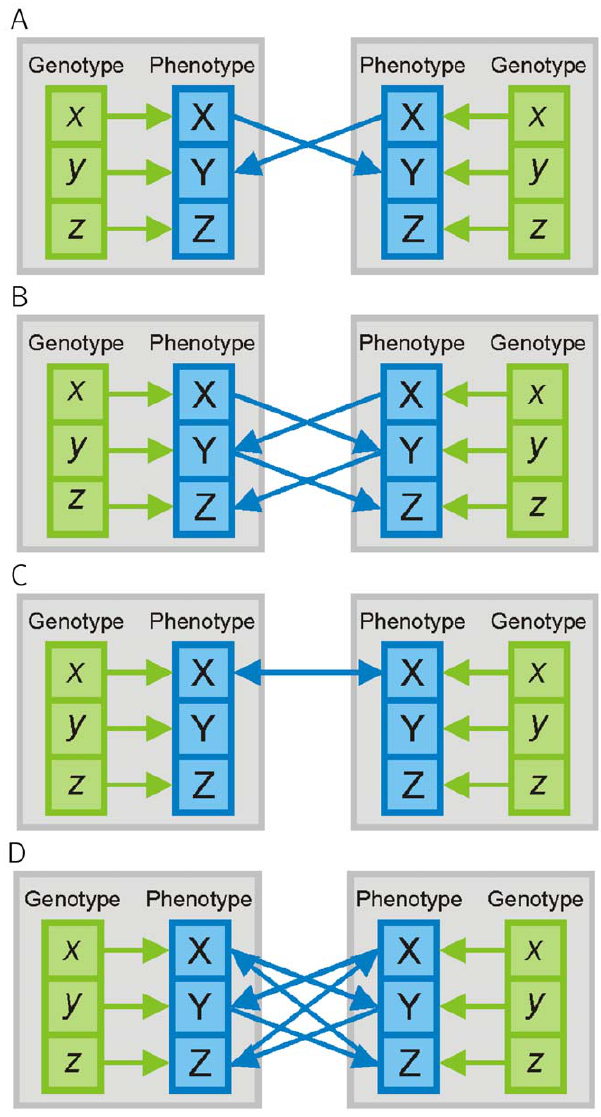
Figure 1. Different classes of interactions. (A) Example of interactions without feedback. (B) Example of interactions with feedback at the individual level. (C, D) Example of interactions with feedback at the trait level: (C) one trait affecting itself. (D) three traits involved in feedback to themselves via multiple interactions. Boxes represent individuals, blue squares represent phenotypic traits, green squares represent genes. Blue arrows represent matrix Y , green arrows represent matrix C